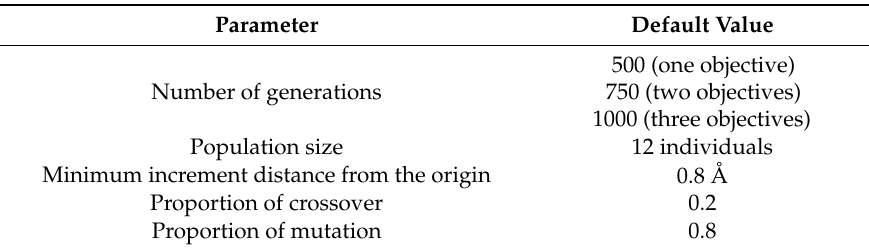
Table 5. Default values for the genetic algorithm